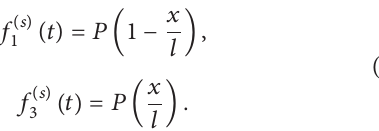
Figure 6: AASHTO-type